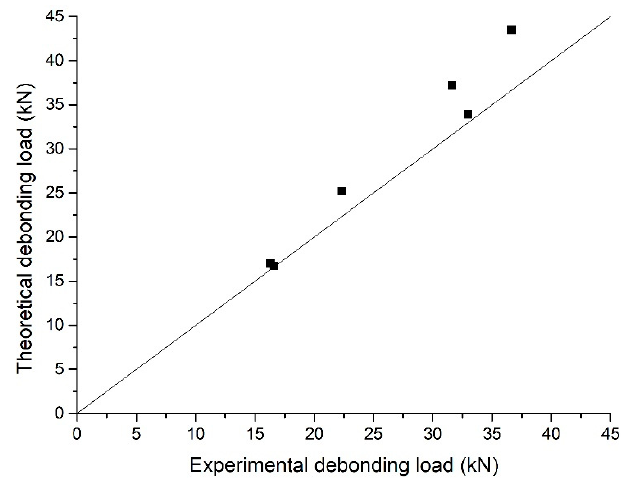
Figure 17. Comparison of theoretical and experimental debonding load.